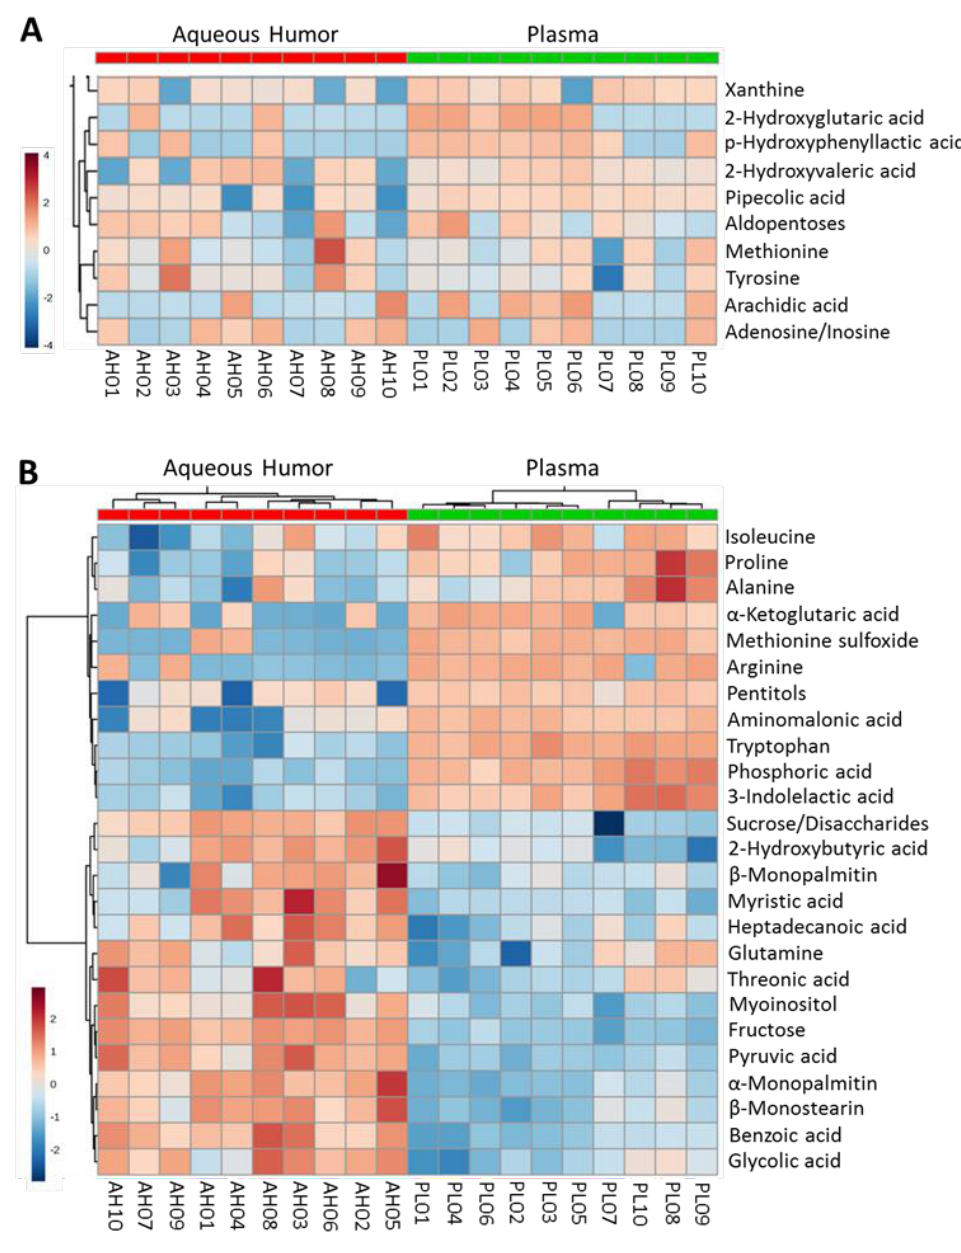
Figure 1. Heatmap analysis of metabolite levels identified in parallel aqueous humor and corresponding plasma samples as measured by gas chromatography mass spectrometry (GC-MS) (log 2 area under the curve AUC values normalized by median and based on n = 10 pooled samples obtained from normoglycemic C57BL/6 and NOD mice). Data shown are for metabolites that are most ( A ) equally and ( B ) differently distributed between the aqueous humor and plasma.